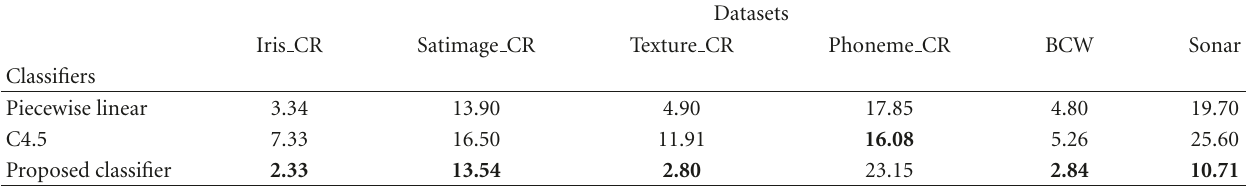
Table 4: Error rates for piecewise linear classifier [32], C4.5 decision tree [33] and the proposed classifier on several datasets. The best results are highlighted in